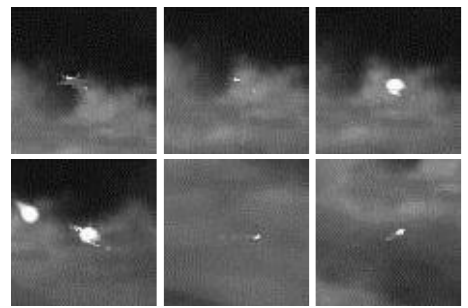
Figure 1. The challenge of airborne infrared target tracking. The aircraft is partly occluded by the cloud and the infrared decoy. Meanwhile, the appearance of the aircraft will frequently change due to pose